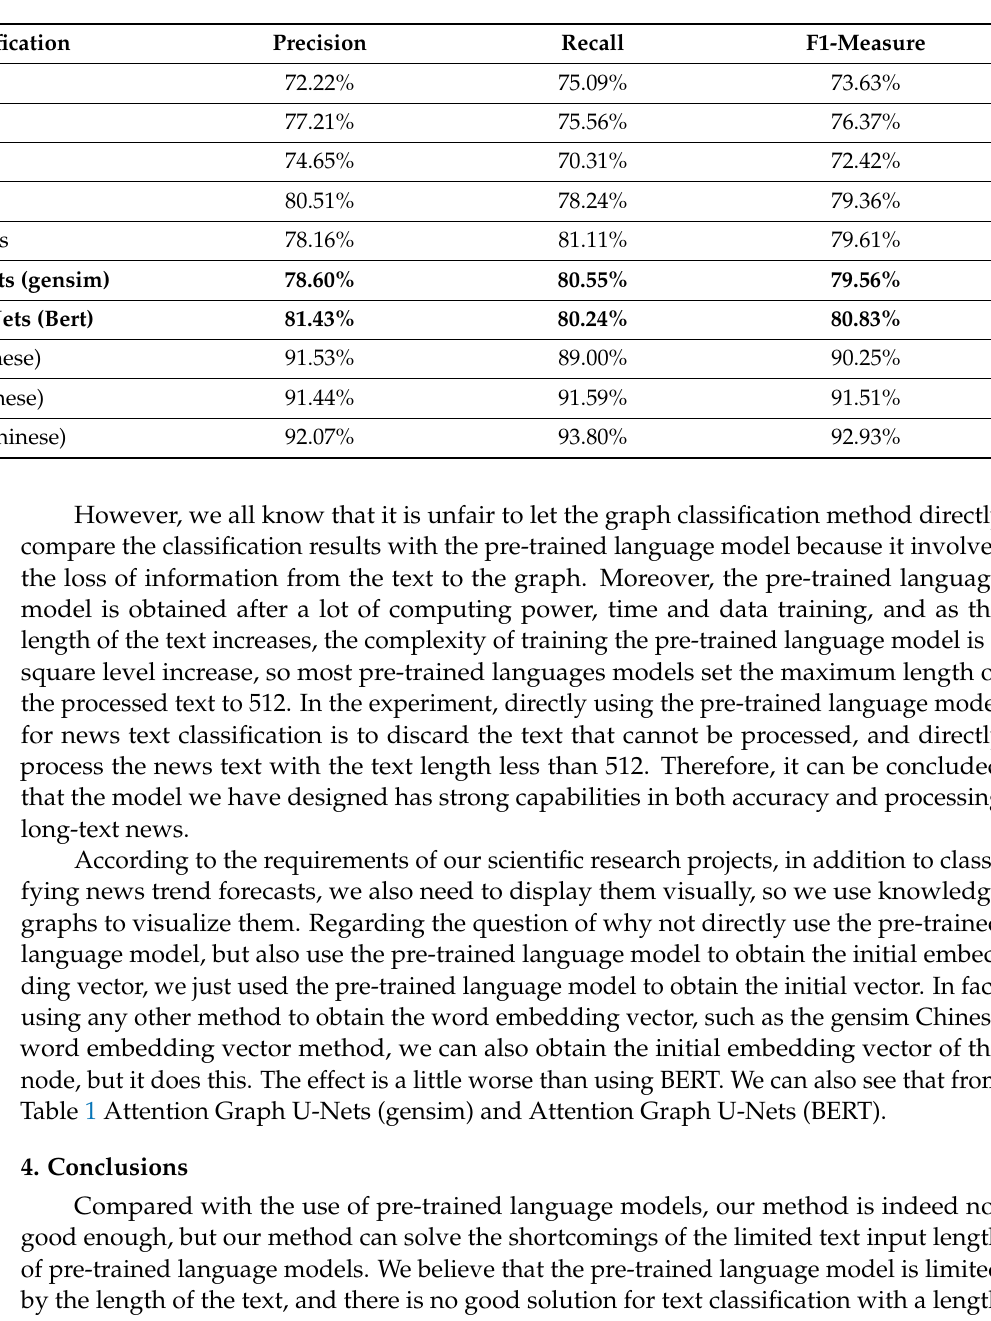
Table 1. Results of learning experiments in terms of node classification accuracies on our dataset. Attention graph U-Nets denotes our proposed